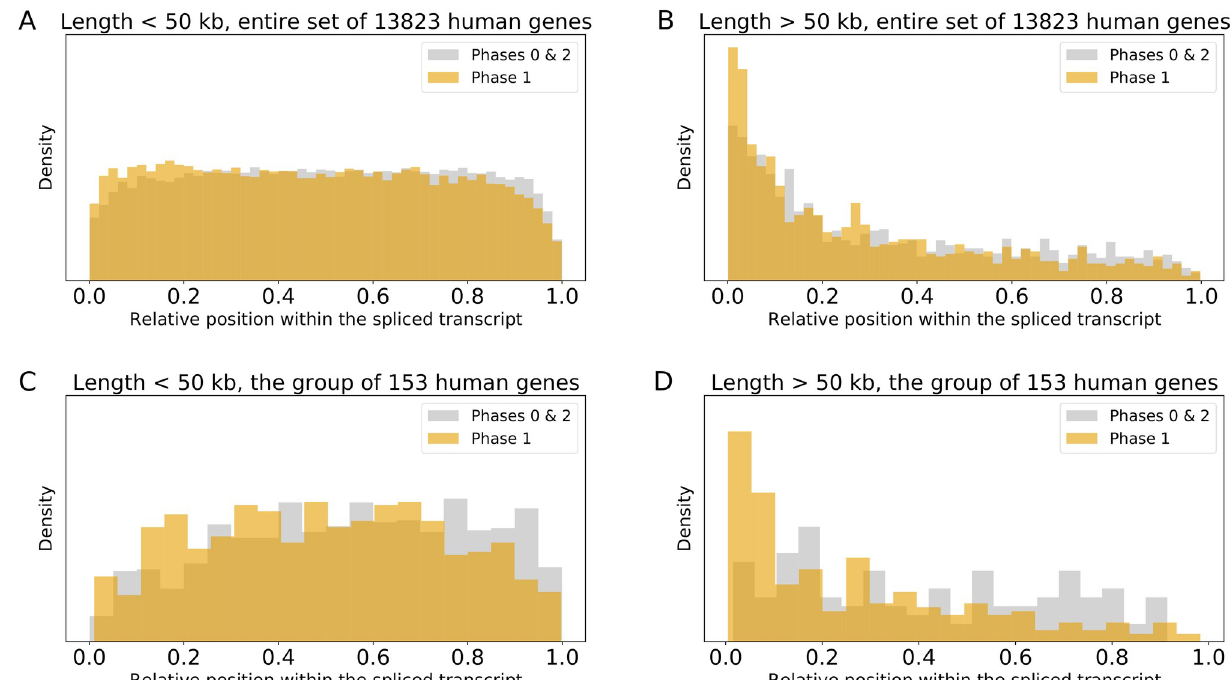
Fig 2. Distribution of relative intron positions along the transcripts. (A) Introns shorter than 50 kilobases of the entire set of considered human genes. (B) Introns longer than 50 kilobases of the entire set of considered human genes. (C) Introns shorter than 50 kilobases of the group of 153 genes. (D) Introns longer than 50 kilobases of the group of 153 genes. Y axis: distribution density, X axis: the relative position of an intron within the spliced transcript. Phase 1 introns are shown in orange, phase 2 and 0 introns are shown together in gray.